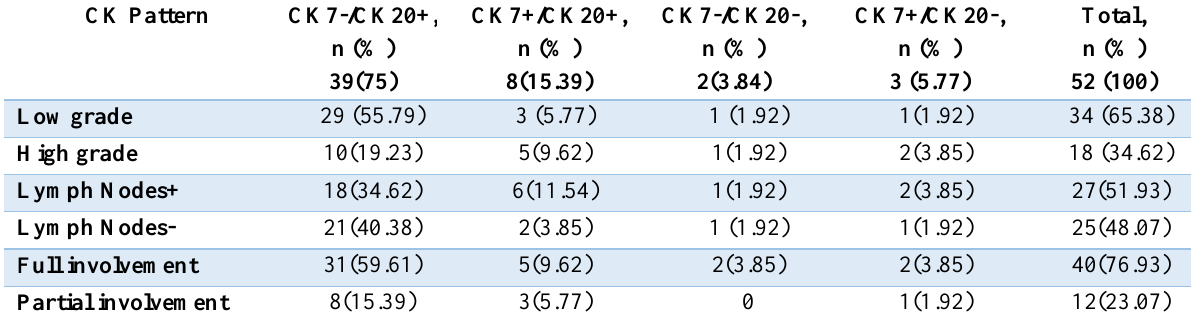
Table 2. CK7/CK20 Expression Patterns and Clinicopathological Findings in Colon Adenocarcinoma